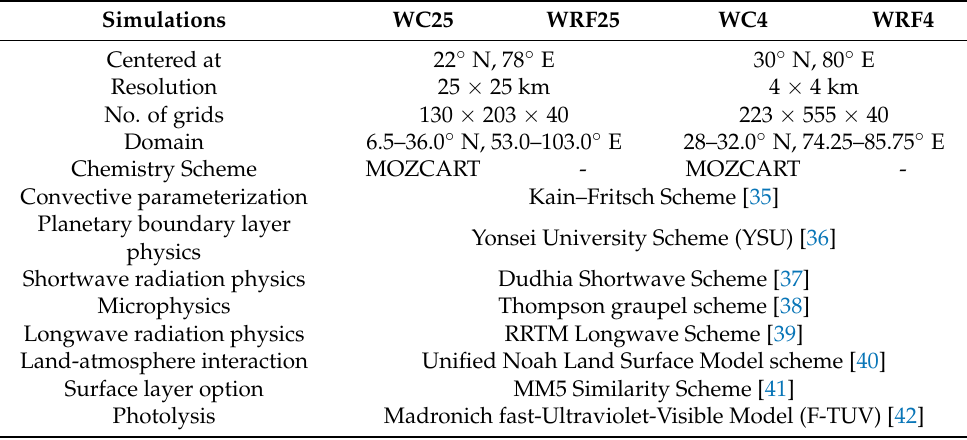
Table 1. Domain and parameterization details for different